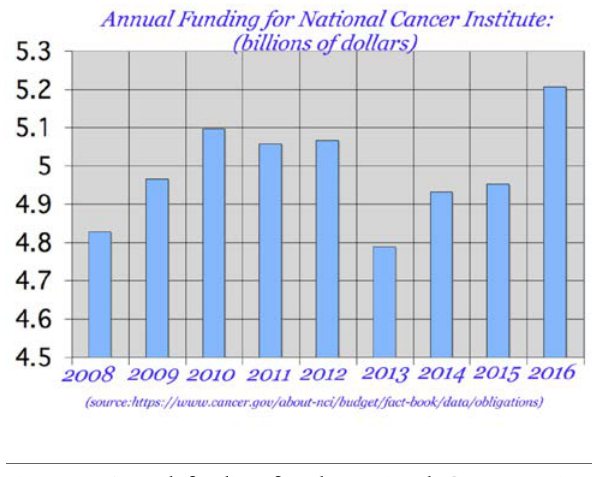
Figure 2. Annual funding for the National Cancer Institute (NCI) from 2008 to 2016 in billions of